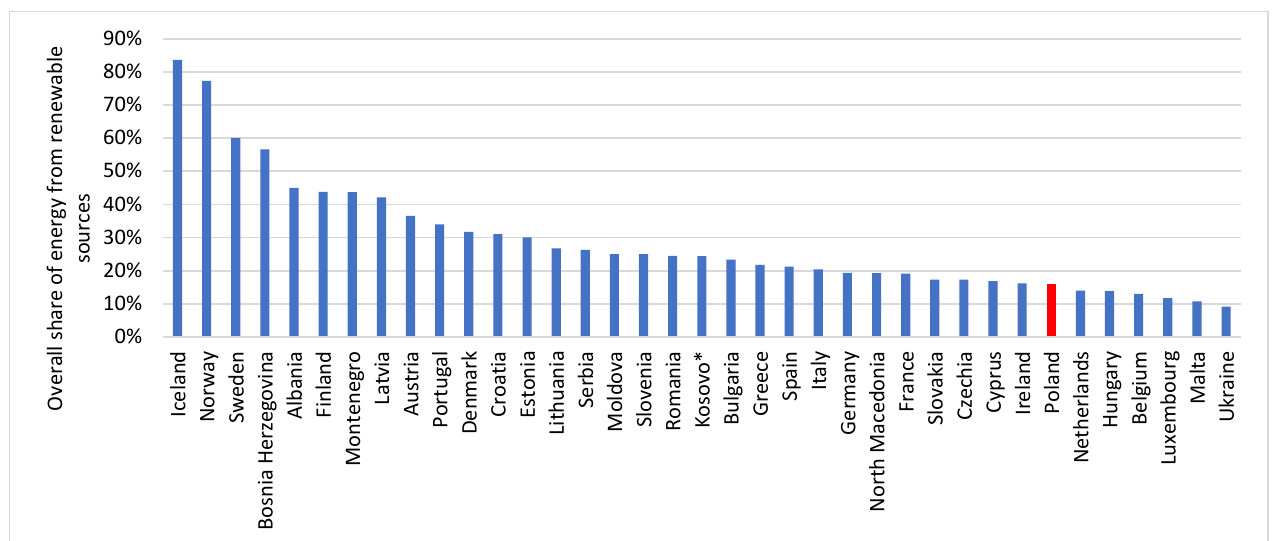
Figure 5. Overall share of energy from renewable sources, 2004 – 2020, EU27 from 2020 (%). Source: own elaboration on the basis of data from https://ec.europa.eu/eurostat/web/energy/data/shares, accessed on 11 November 2022.